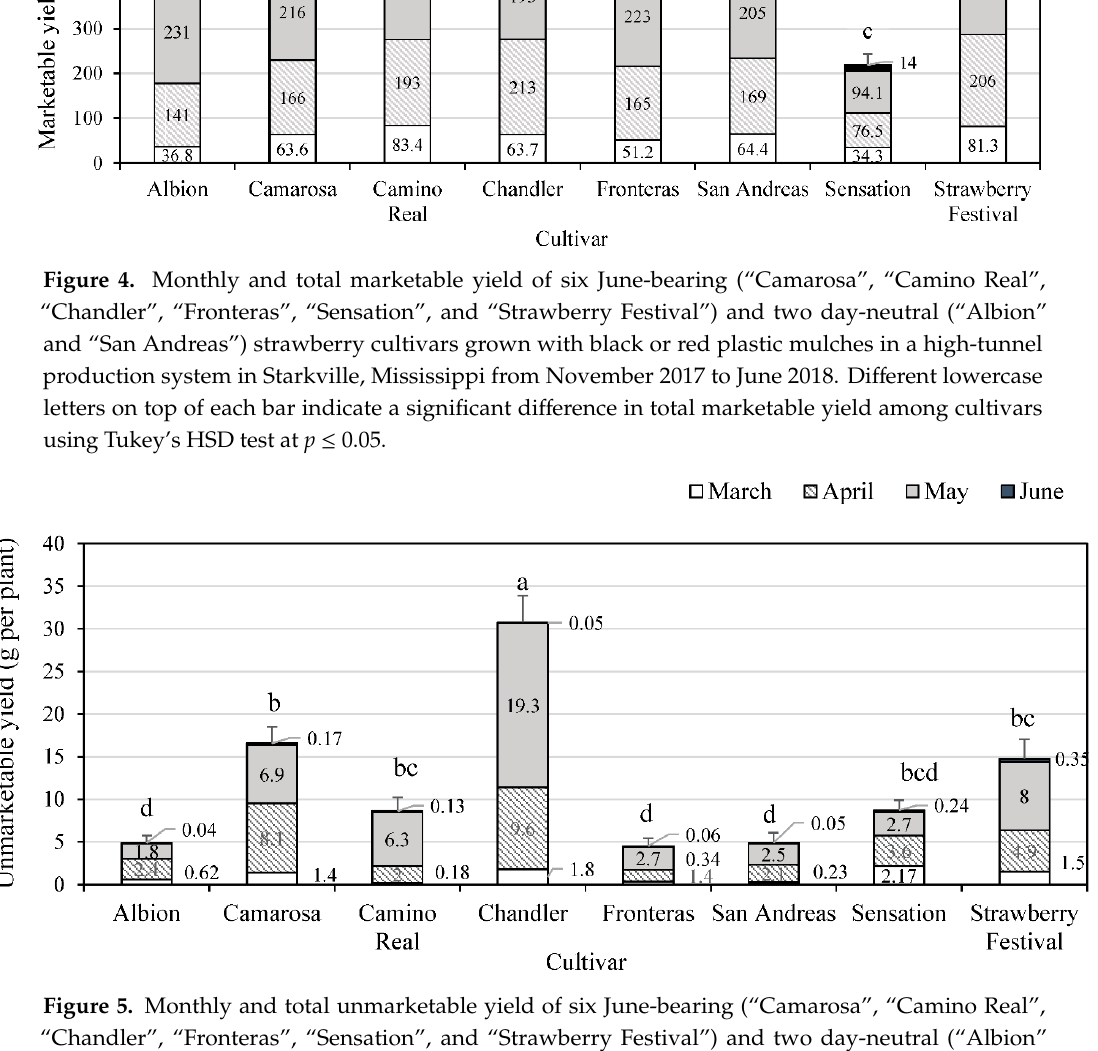
Table 4. Monthly marketable and unmarketable yields of strawberry cultivars affected by plastic mulch type grown in a high tunnel in Starkville, Mississippi from November 2017 to June 2018. Unmarketable Yield Marketable Yield (g per Plant) z (g per Plant) Mulch March May March May Black 63.7 202 0.7 5.3 Red